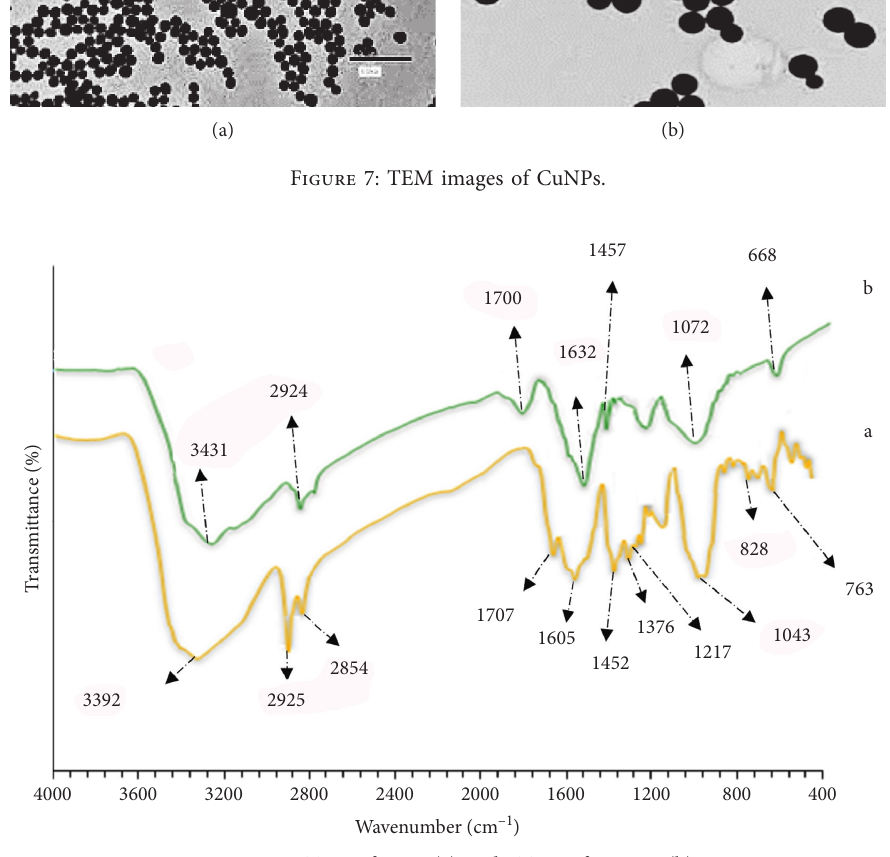
Figure 8: FT-IR of PHE (a) and FT-IR of CuNPs (b).